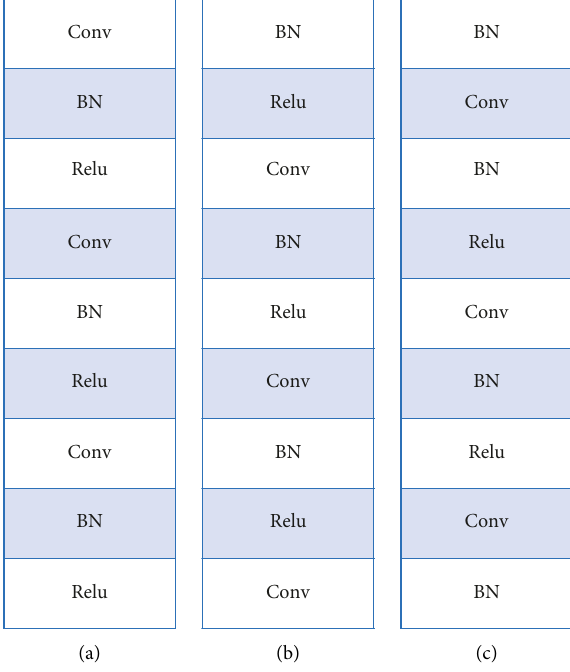
Figure 5: Location of BN and relu in the network. (a) Model a. (b) Model b. (c) Model